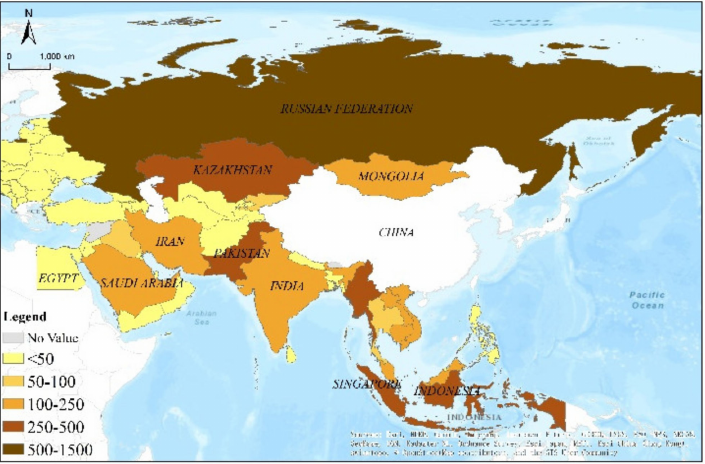
Figure 1. China’s OFDI in the Belt and Road countries during